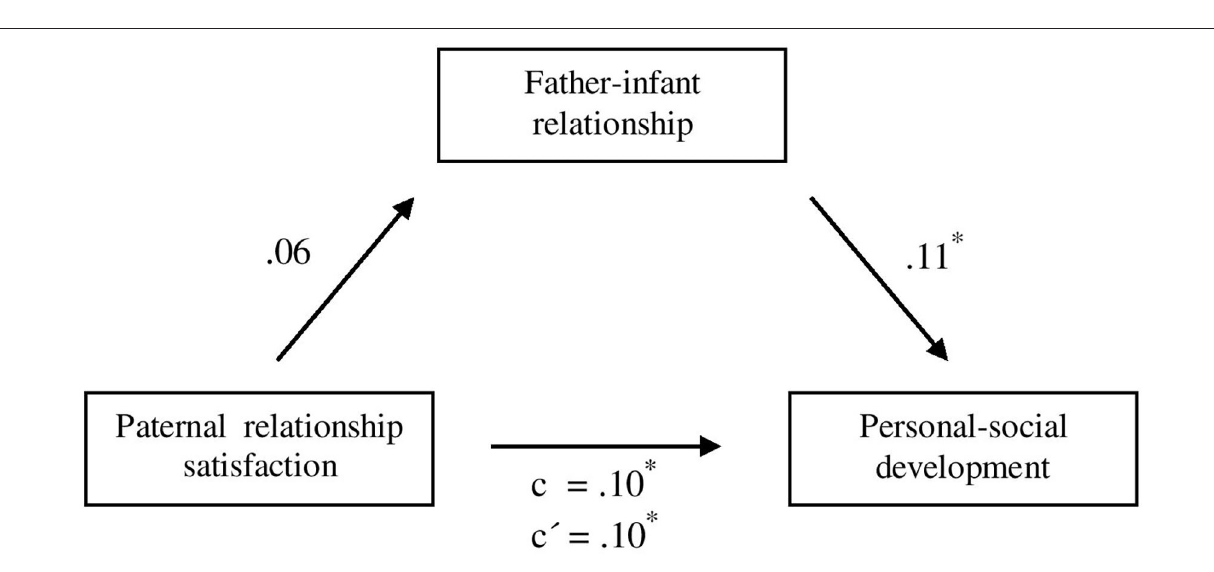
relationship satisfaction may predict development in